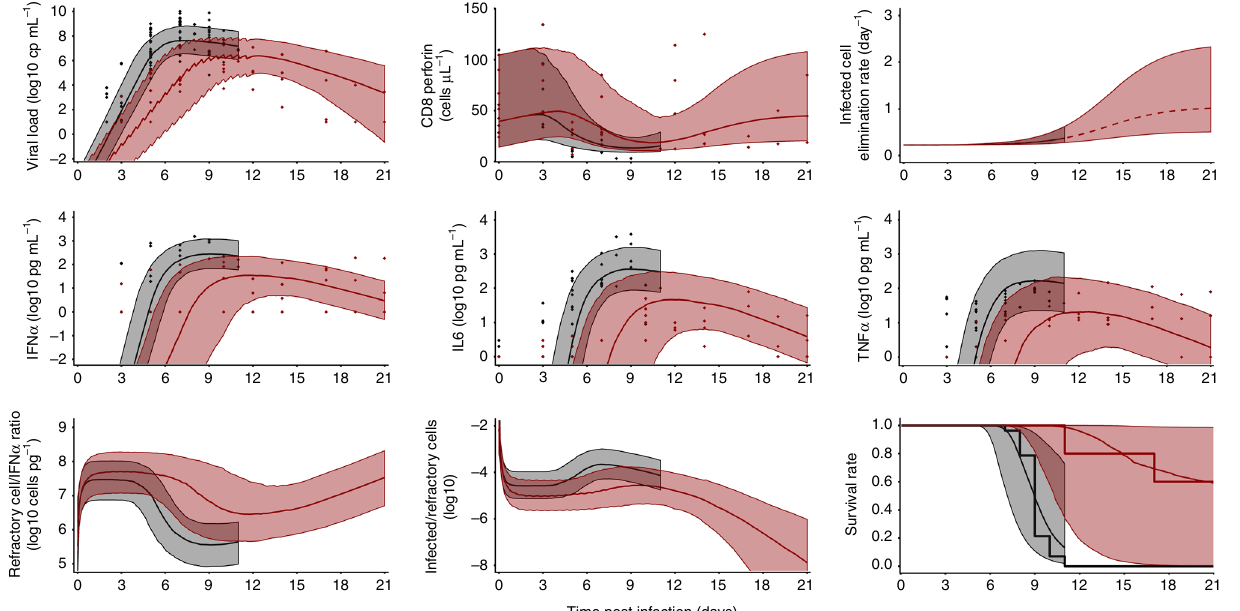
Fig. 5 Individual observation (dots) and median model predictions (line) in animals left untreated (black) or treated with 180 mg kg − 1 BID favipiravir (red). Top left: Ebola virus viral load; top middle CD8 T cells expressing perforin; top right: model prediction of productive infected cell elimination rate, increasing concomitantly to adaptive response; middle left: IFN α concentrations; middle: IL6 concentration; middle right: TNF α concentration; bottom left: predicted ratio of protected cells on the concentration of IFN α ( R / F ); bottom middle: model prediction of the ratio of infected on protected cells ( R / I 2 ); bottom right: Kaplan Meier curves and survival rate prediction. Shaded areas represent the predictions within the 10th and 90th percentiles of 1000